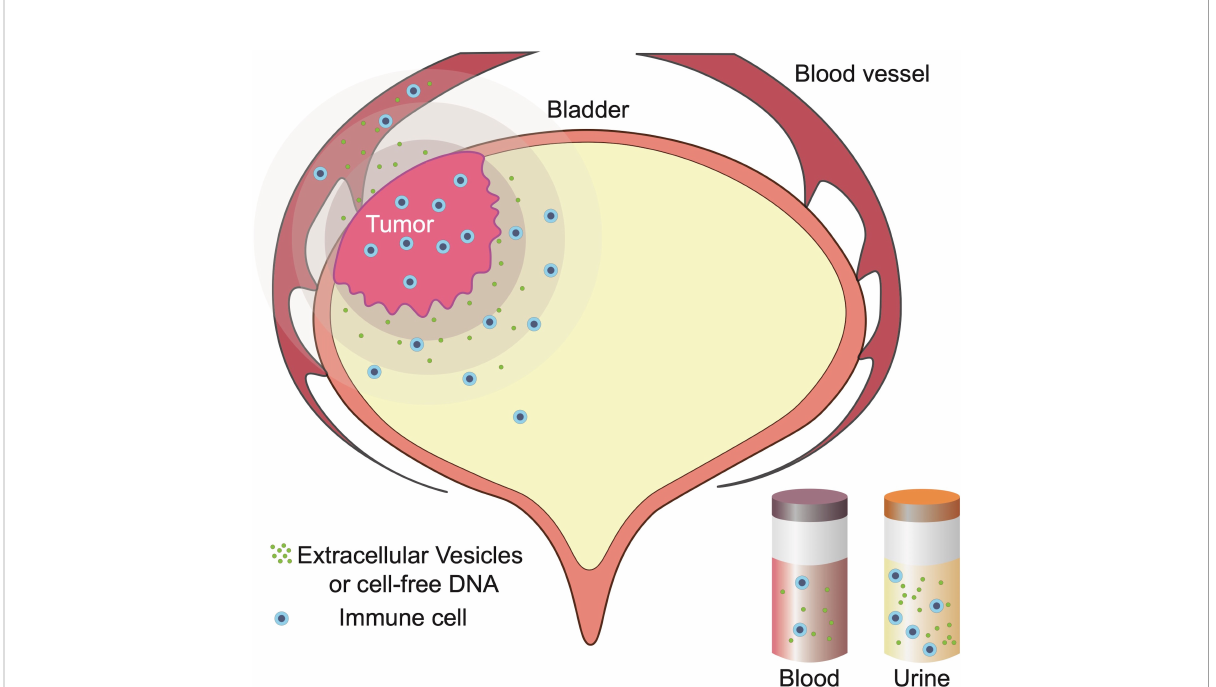
FIGURE 2 Blood fl owing through bladder cancer (BC) tissue and urine that comes in contact with BC tissue re fl ects changes to the tumour microenvironment (TME). Currently, free cells and molecules in the urine may be shed from the tumour, similar to infused lymphocytes and molecules in